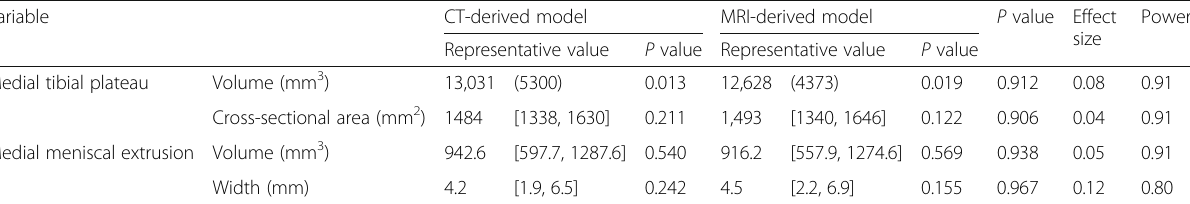
Table 2 Demographic of volume and cross-sectional area of the medial tibial plateau models and volume and width of the medial meniscal extrusion